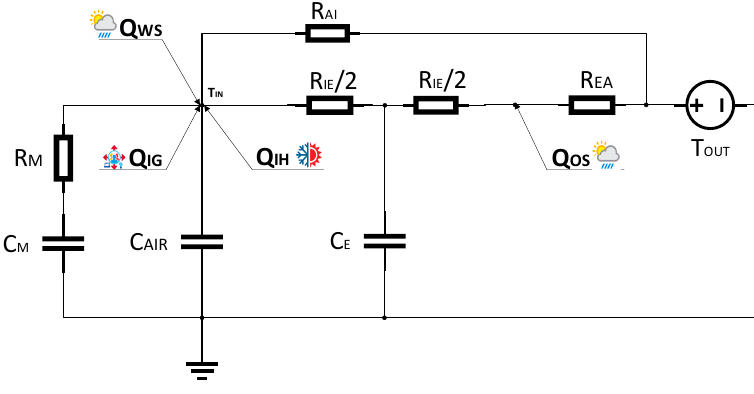
Figure 1. The ModSCO ROM RC-network